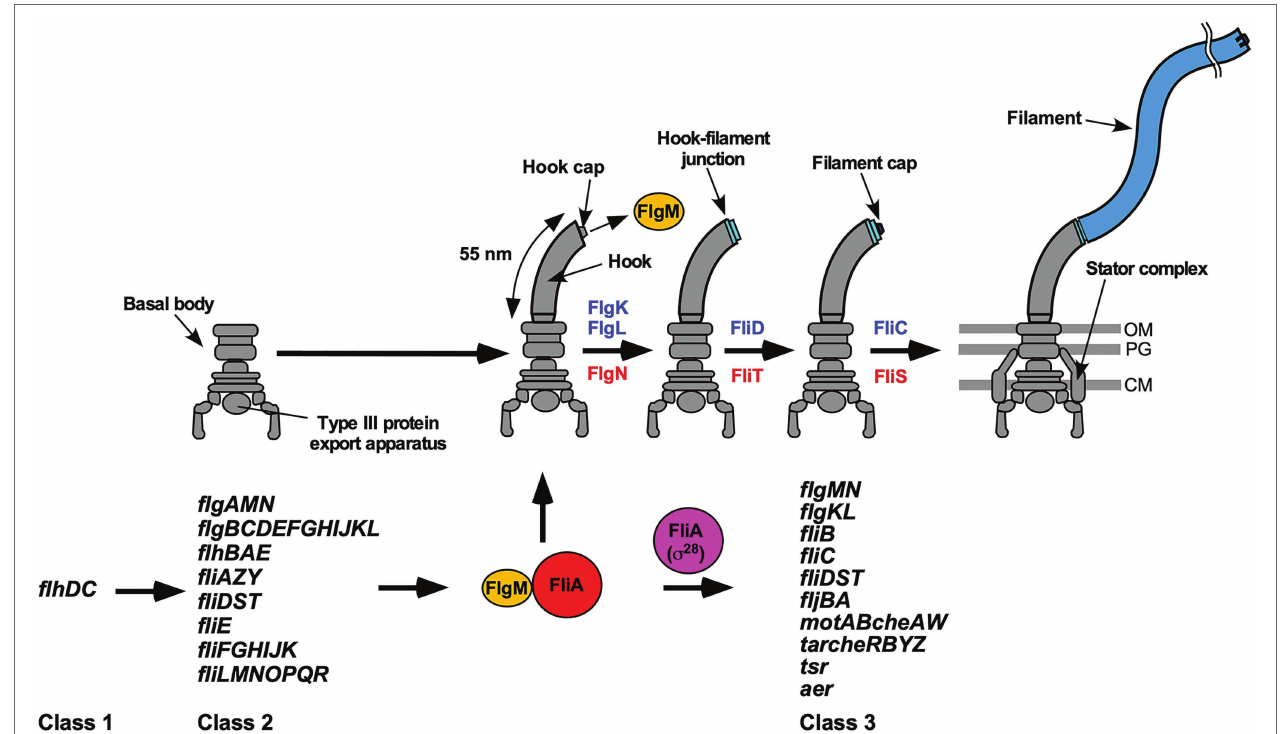
FIGURE 1 | Flagellar assembly and hierarchical flagellar gene expression. Flagellar assembly begins with the basal body, followed by the hook (FlgE) with the help of the hook cap (FlgD). Upon completion of hook assembly, the hook cap is replaced by FlgK. FlgK and FlgL self-assemble at the hook tip in this order to form the hook-filament junction structure. Then, FliD forms the filament cap at the tip of the junction and promotes the assembly of FliC into the long helical filament. During hook-basal body (HBB) assembly, FlhD and FlhC, which are class 1 gene products, act as a transcriptional activator to induce the transcription of class 2 genes required for HBB formation. When the hook length reaches its mature length of 55 nm in Salmonella , the flagellar type III secretion system (fT3SS) switches its substrate specificity from rod- and hook-type proteins to filament-type ones, thereby terminating hook assembly and filament assembly at the hook tip. As a result, FlgM is secreted via the fT3SS into the culture media, and so FliA acts as a flagellum-specific sigma factor ( σ 28 ) to transcribe class 3 genes encoding proteins required for filament formation, motility, and chemotaxis. FlgN, FliT, and FliS act as flagellar export chaperones specific for FlgK/FlgL, FliD, and FliC, respectively. These chaperones facilitate the docking of their substrates to the fT3SS for efficient and rapid protein unfolding and export. Except for the fliC gene, the flgKL , flgMN , and fliDST genes are transcribed from both class 2 and class 3 promoters. OM, outer membrane; PG, peptidoglycan layer; CM, cytoplasmic